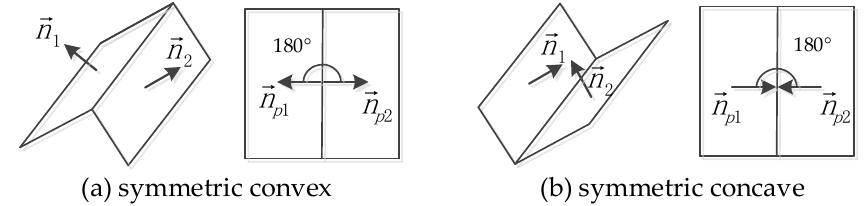
Figure 6. The local symmetry of adjacent planes.